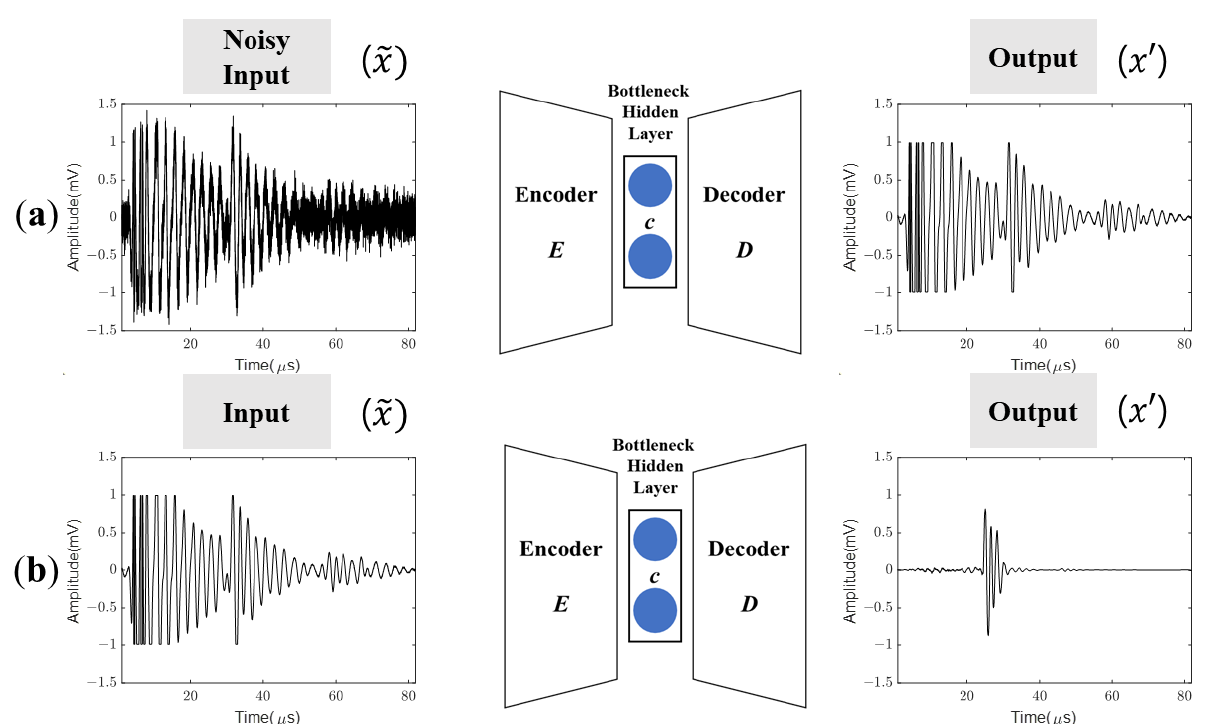
Figure 5. Difference between ordinary denoising autoencoder and one used in this study: ( a ) the inputs (𝑥̃) and outputs (𝑥 ′ ) of the ordinary denoising autoencoder that the noisy input is denoised throughout the autoencoder; ( b ) the inputs (𝑥̃) and outputs (𝑥 ′ ) of the DAE used in this study that the autoencoder extracts the flaw signal out of the mixed signal and denoises the other extra signals beside the flaw signal.